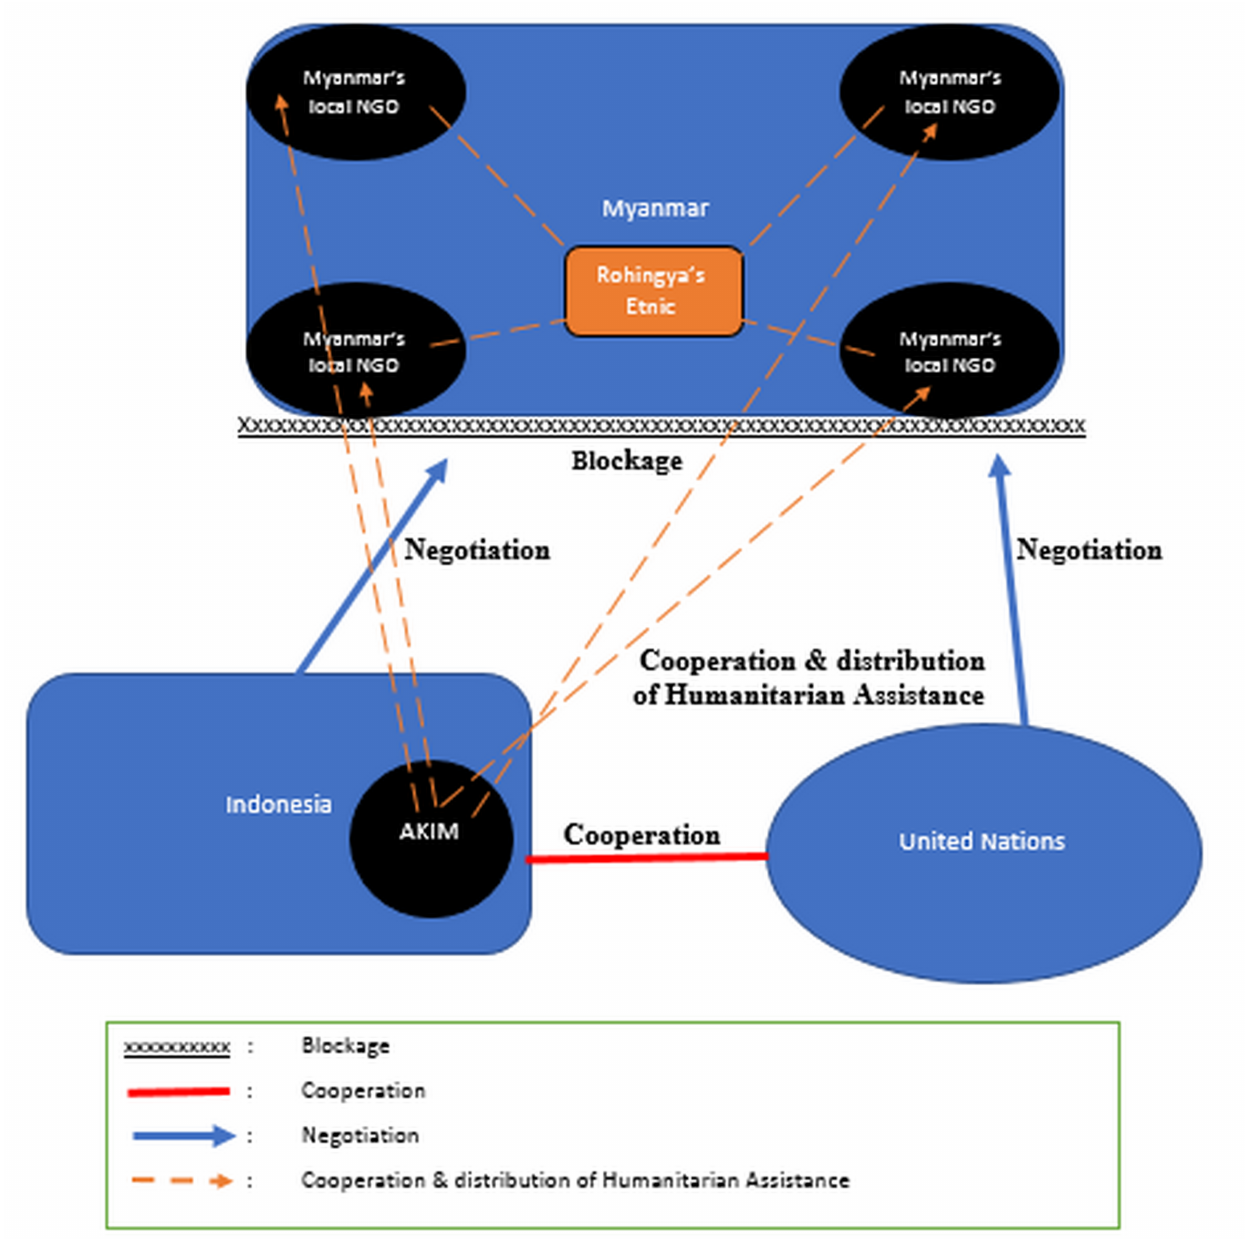
Figure 2. The Role of the Indonesian Humanitarian Allience for Myanmar (AKIM) in Handling the Rohingya Ethnic Humanitarian Crisis in